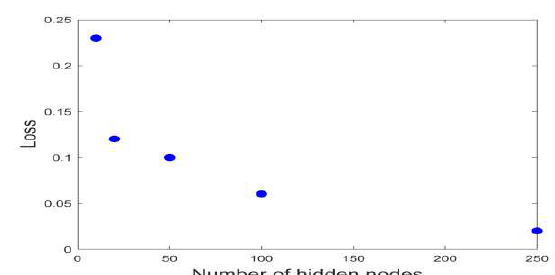
Figure 6. The loss values of reconstruction models based on the numbers of hidden nodes.